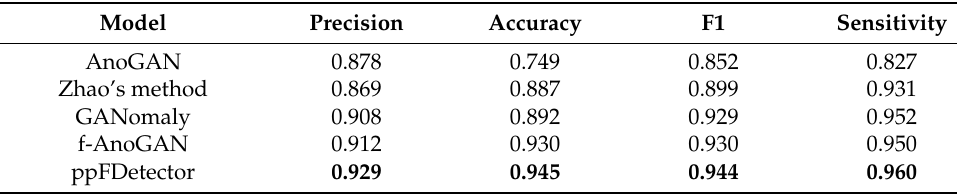
Table 4. Performance comparison with semi-supervised and unsupervised models.